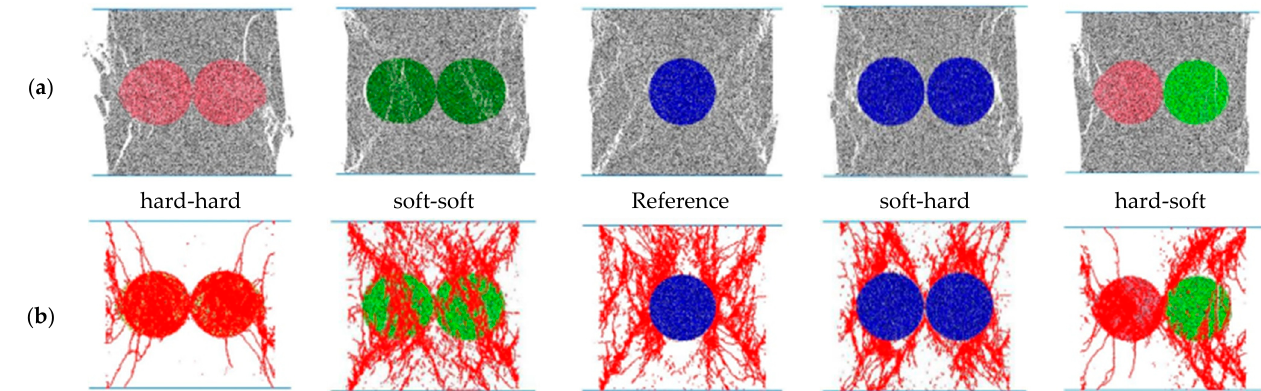
Figure 13. Typical failure modes of specimens in Group 5: ( a ) failure mode of specimen; ( b ) failure mode of concretion.